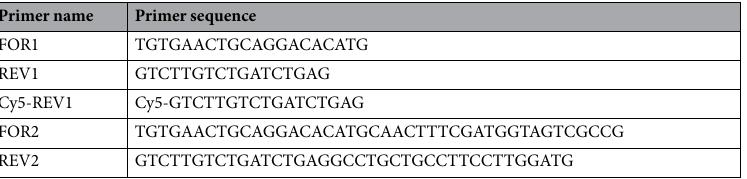
Table 4. Universal primers for ITS2 amplification and long primers for positive template